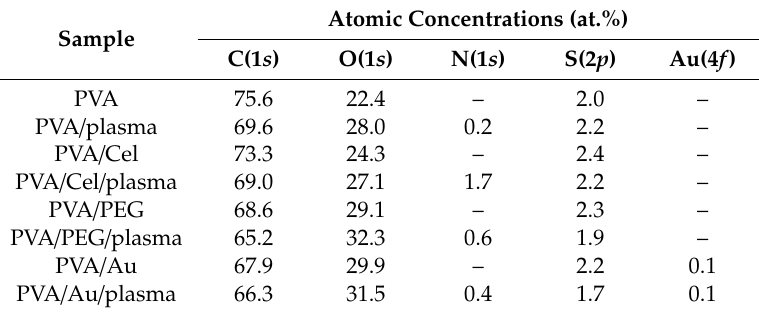
Table 2. Atomic concentrations of selected elements C(1 s ), O(1 s ), N(1 s ), S(2 p ) and Au(4 f ) measured by XPS in PVA foils non-treated or treated with plasma, which were either non-doped (PVA) or were doped with cellulose (PVA/Cel), with poly(ethylene glycol) (PVA/PEG) or with Au nanoparticles in a PEG colloid solution (PVA/Au).